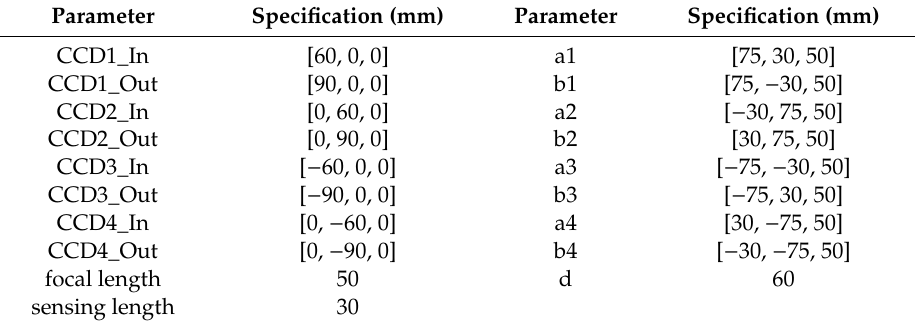
Table 1. Simulation Parameters.